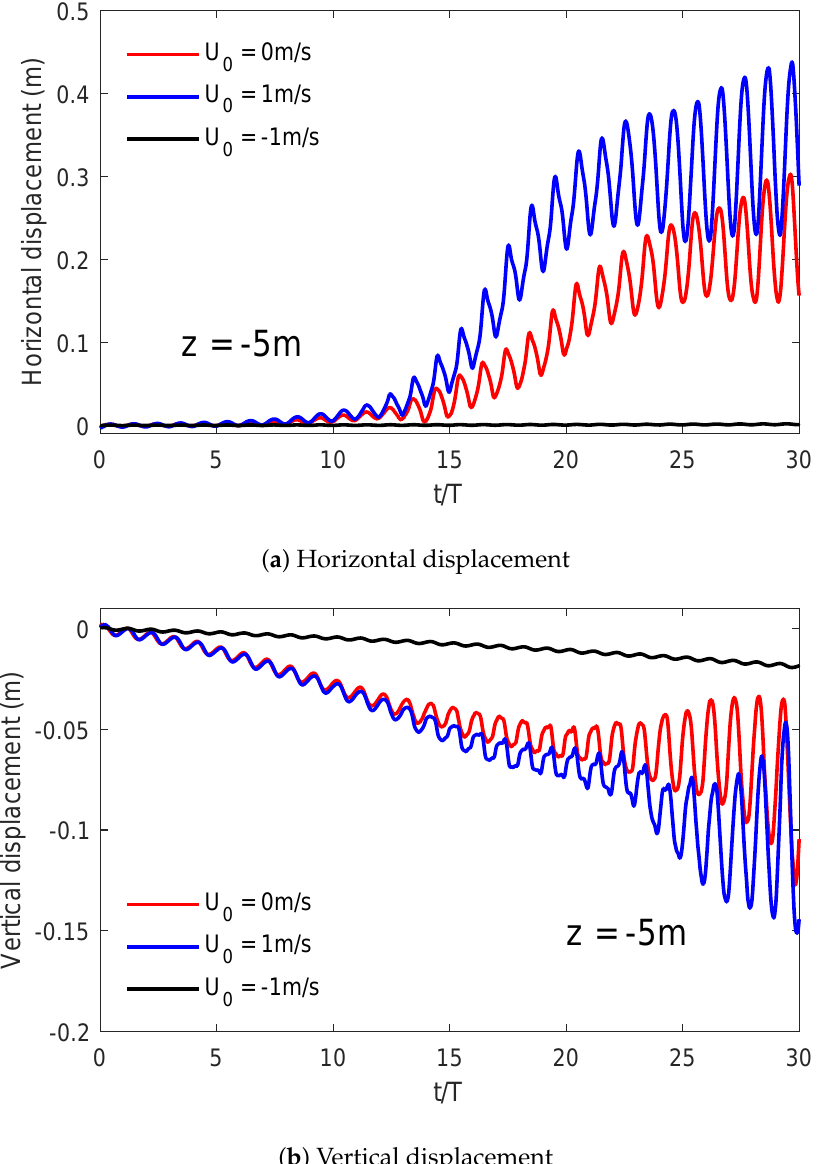
Figure 9. Displacements under different current conditions: ( a ) horizontal displacement, ( b ) vertical